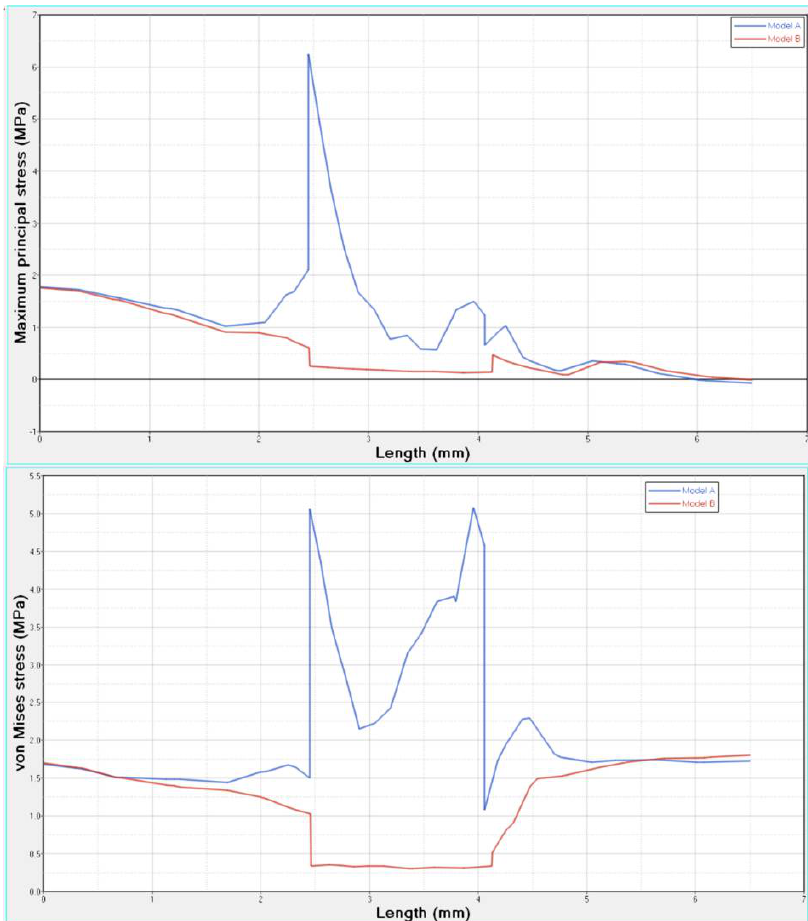
Figure 14. Maximum principal stress and von Mises stress distributions in the cross-section at the cervical margin, along the direction indicated by the red line shown in Figure 12.